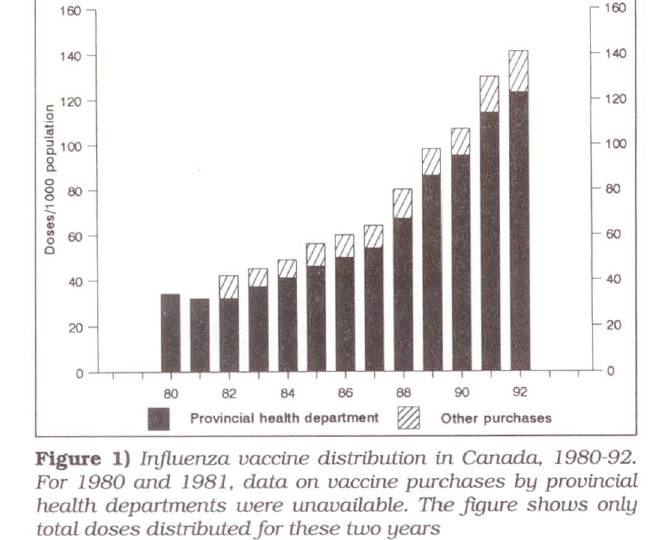
Measures to improve surveillance of the impact of influ enza and its prevention in